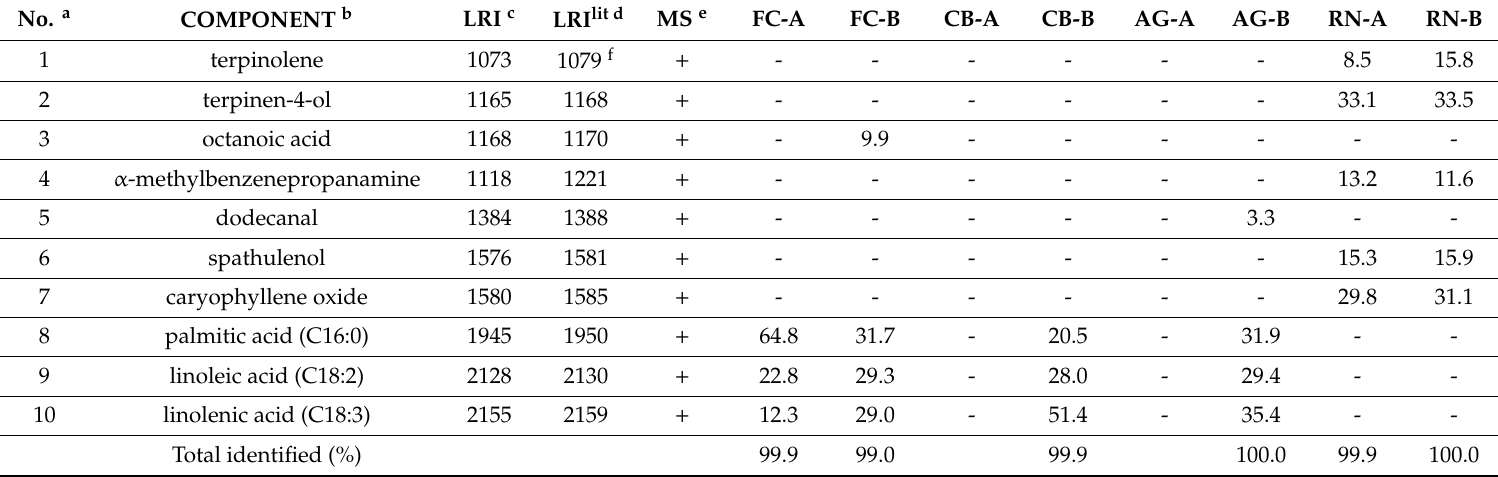
Table 2. Volatile chemical components (%) of